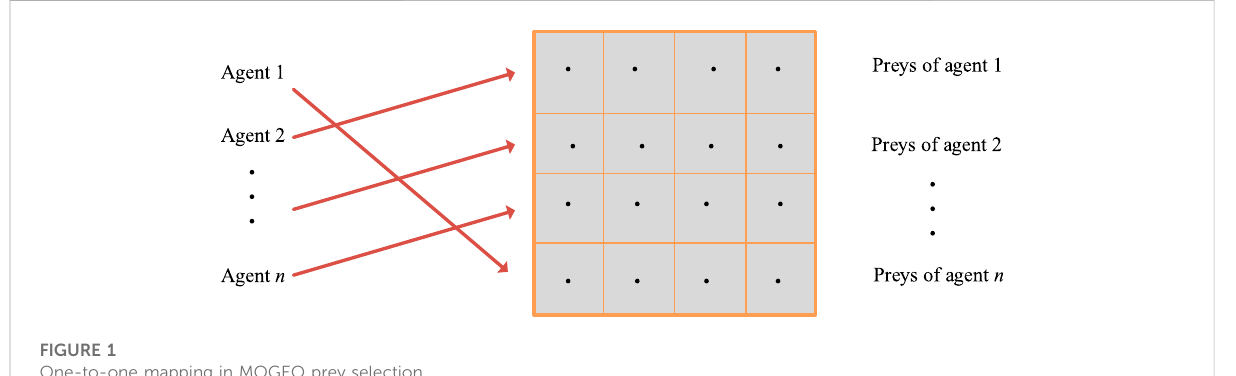
FIGURE 1 One-to-one mapping in MOGEO prey selection.